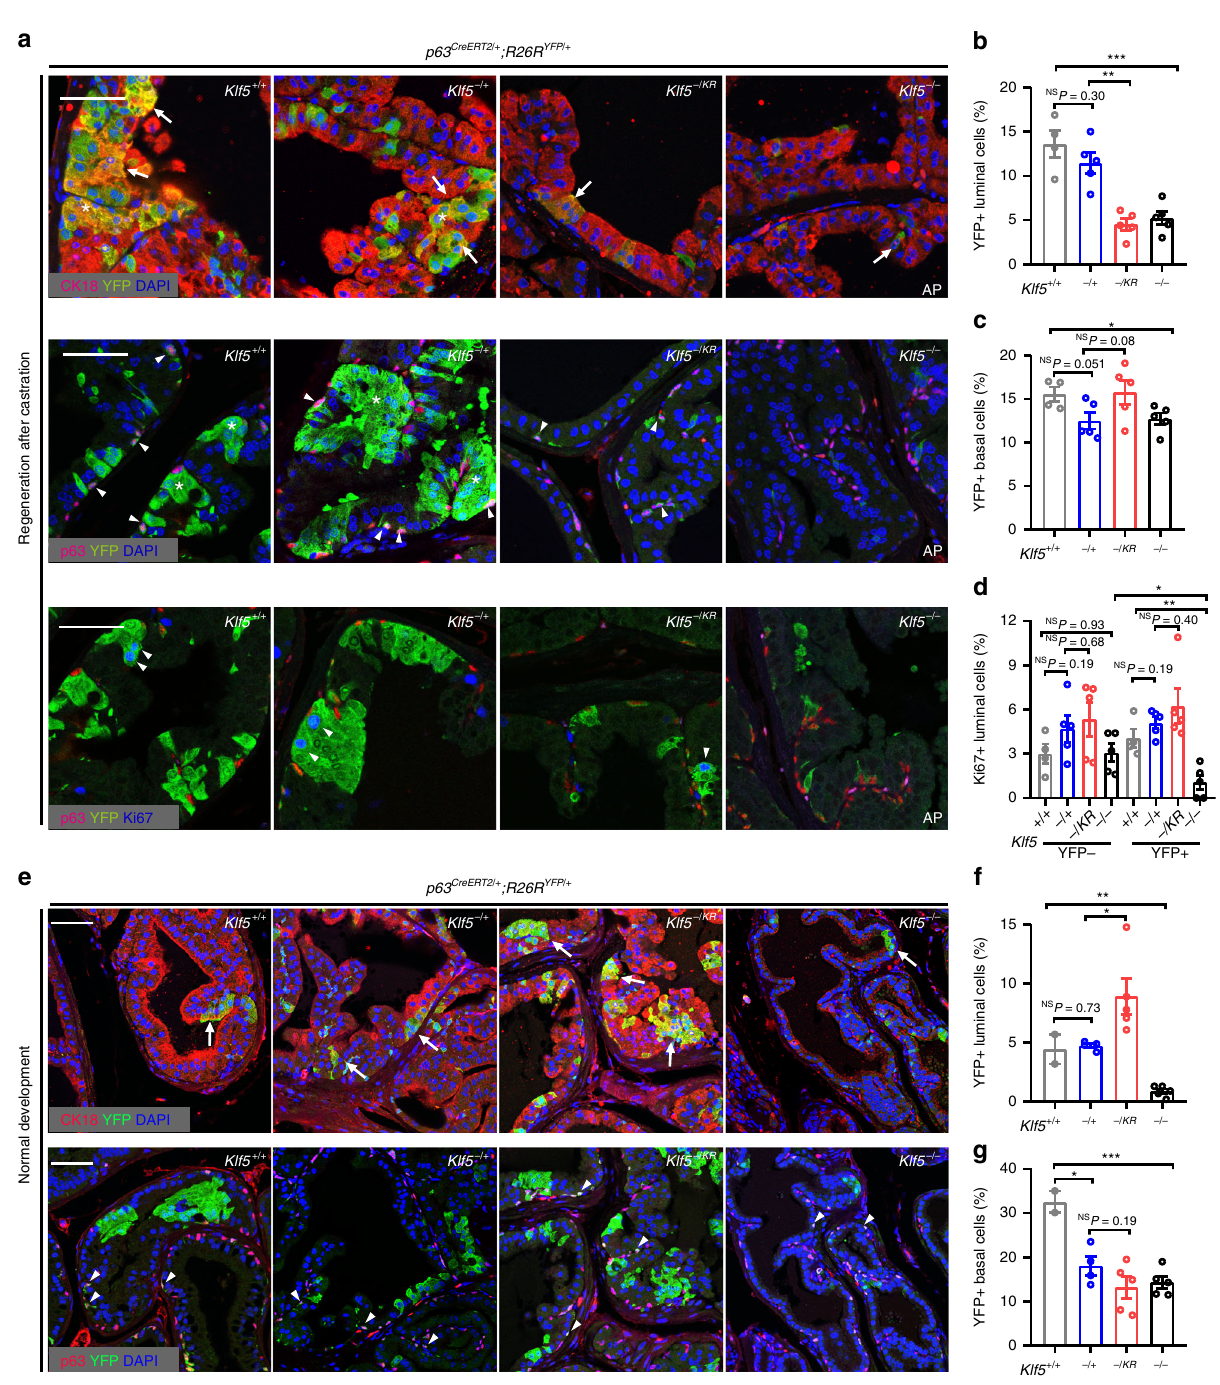
Fig. 8 Deacetylation of Klf5 compromises androgen-induced regeneration of basal progenitor-derived luminal cells. Knockin of Klf5 KR was induced by tamoxifen at postnatal day 18 for 5 consecutive days, and YFP + basal or luminal cells were analyzed by IF staining after one castration-regeneration cycle ( a – d ) or 16-week normal development ( e – g ). a – c Knockin of Klf5 KR prevented the re-emergence of luminal cells ( b ) but did not have a detectable effect on basal cells ( c ) in regenerated prostates, as detected by IF staining of luminal (YFP + /CK18 + ) and basal (YFP + /p63 + ) cells. Arrows point to YFP + /CK18 + cells, and arrowheads to YFP + /p63 + cells. d Knockin of Klf5 KR maintained, while homozygous deletion of Klf5 signi fi cantly reduced, the proliferation rate in luminal cells. IF staining of p63 was used to mark basal cells ( a , lower). YFP- cells were used as internal controls. In b – d , the numbers of mice used were as follows: Klf5 + / + , n = 4; Klf5 − / + , n = 5; Klf5 − /KR , n = 5; Klf5 − / − , n = 5. e – g Knockin of Klf5 KR still increased luminal cells ( f ), but did not signi fi cantly affect basal cells ( g ), as detected by IF staining ( e ) of luminal cells (YFP + /CK18 + ) and basal cells (YFP + /p63 + ). Arrows point to YFP + /CK18 + luminal cells, and arrowheads to YFP + /p63 + basal cells. In f , g the numbers of mice are as follows: Klf5 + / + , n = 2; Klf5 − / + , n = 4; Klf5 − /KR , n = 5; Klf5 − / − , n = 5. Representative images are selected based on the statistical analysis. Scale bars, 50 μ m. Data are shown in mean ± S.E.M. NS not signi fi cant; * P < 0.05; ** P < 0.01, *** P < 0.001 (two-tailed Student ’ s t -test). Source data are provided as a Source Data fi